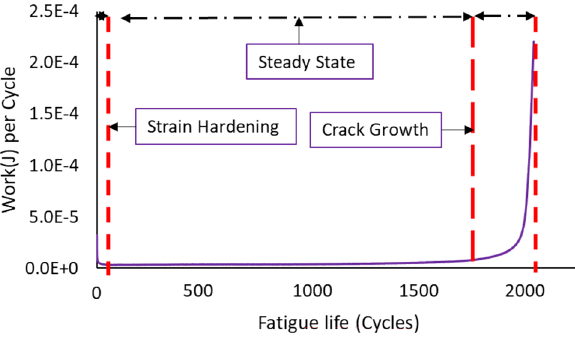
Figure 10. The evolutions in the inelastic work per cycle versus the fatigue